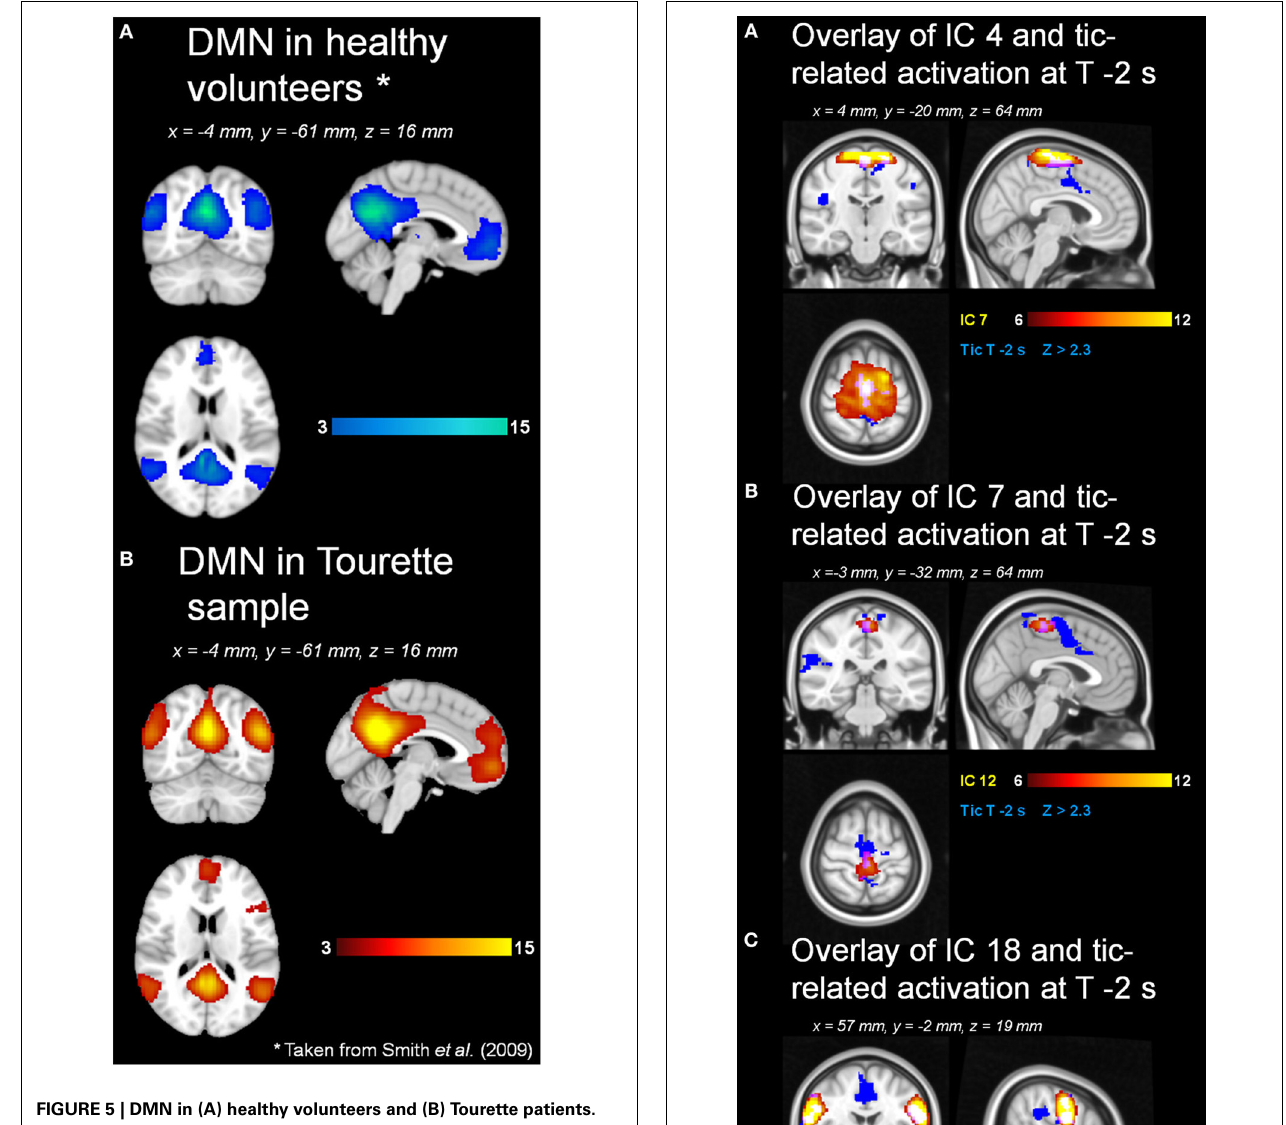
FIGURE 5 | DMN in (A) healthy volunteers and (B) Tourette patients. ∗ Data taken from Smith et al., 2009.